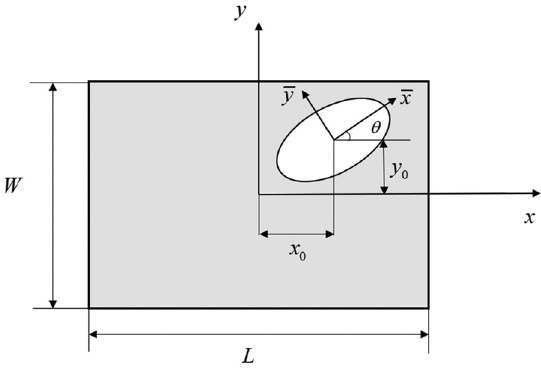
Figure 1: Rectangular plate with ellipse cutout.